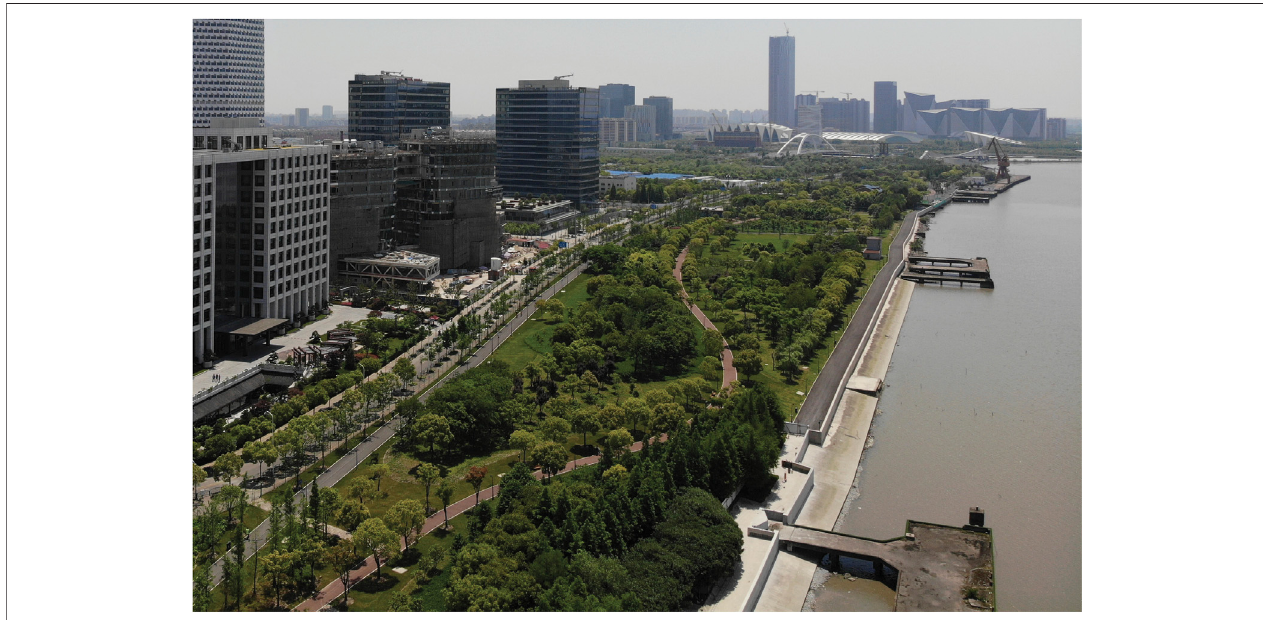
FIGURE 3 | Hard embankments in new ecological park along the Huangpu River (Photo by author, September 2020).